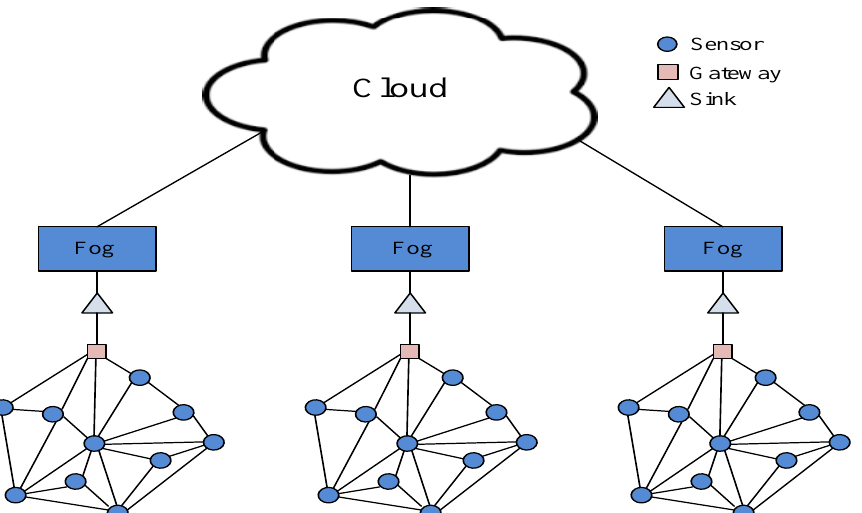
Figure 6. Illustration of multi-hop networks connected to fog nodes through gateway and sink nodes.